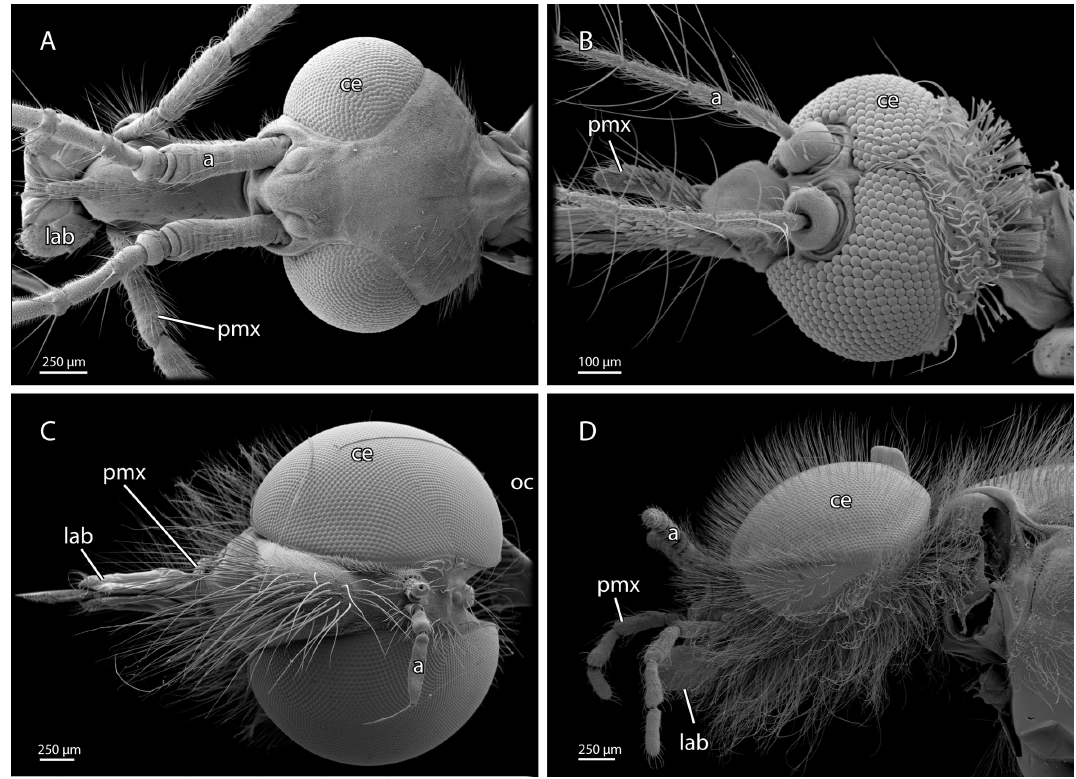
Figure 8 . Head capsule, SEM images. A, Tipula paludosa (Tipulidae), dorsal. B, Culex pipiens (Culicidae), laterodorsal. C, Stilpnogaster aemula (Asilidae), dorsal. D, Bibio sp. (Bibionidae), lateral, copyright Hans Pohl. Abbreviations: a, antenna; ce, compound eye; lab, labella; oc, ocelli; pmx, maxillary